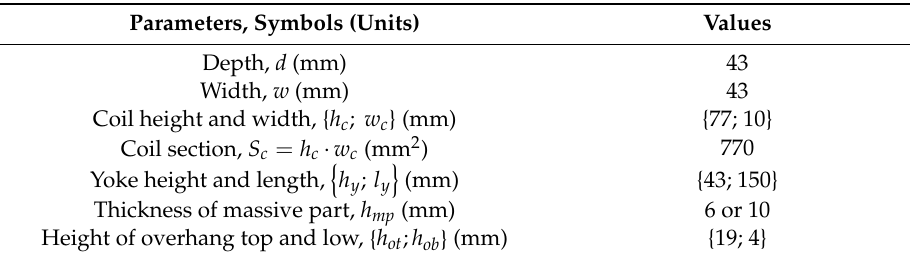
Figure 1. U-cored static electromagnetic device: ( a ) Experimental test [33], and ( b ) geometrical parameters (see Table 1 for the various parameters). Table 1. Geometrical